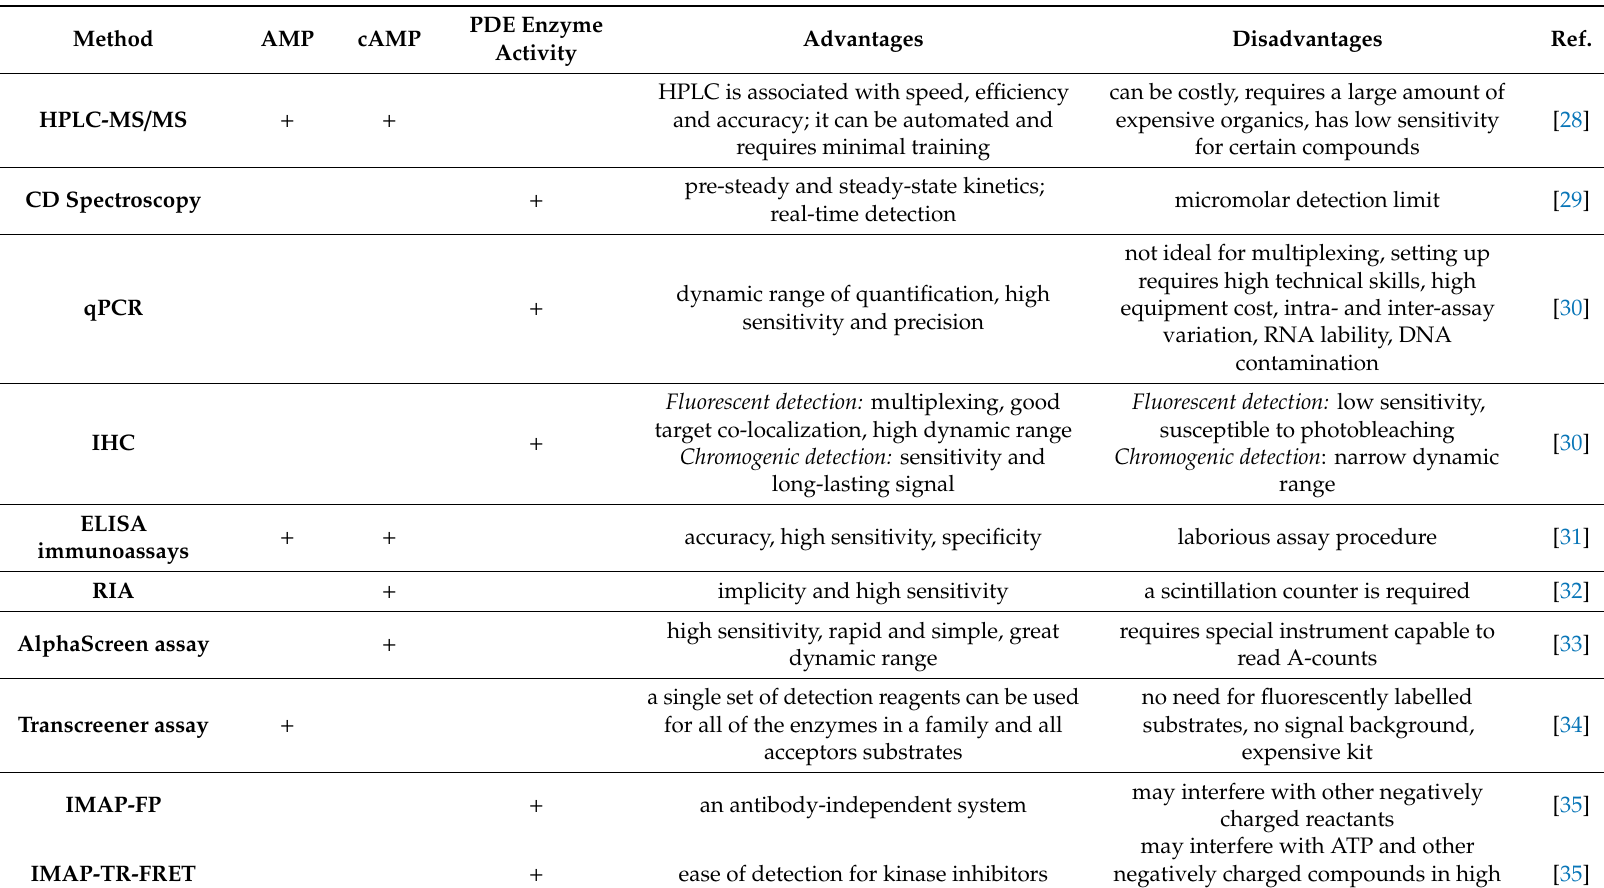
Table 1. Advantages and disadvantages of methods used for the quantification of adenosine monophosphate (AMP) and cyclic adenosine monophosphate (cAMP) or for the measurement of phosphodiesterases (PDE)